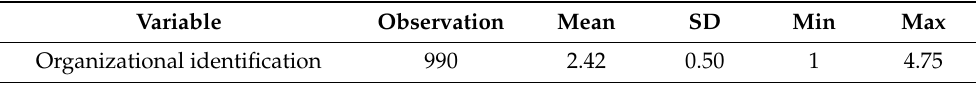
Table 4. Attitudinal variables of the respondents